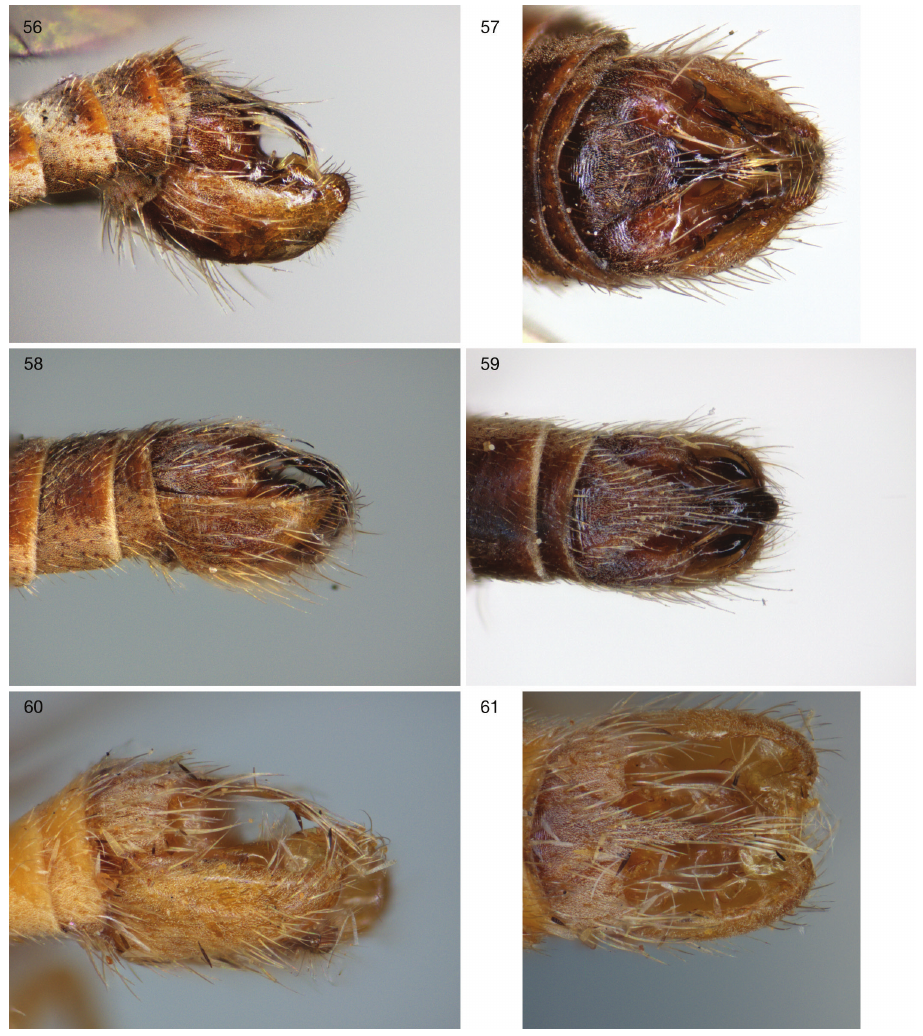
Figures 56–61. Photographs of ♂ terminalia (as in life rotated 180°): 56 Microphontes ericfisheri sp. n. (Holotype, USNMENT01115122), lateral (image flipped horizontally showing right side, Morphbank #861789) 57 same, ventral (#861791) 58 Microphontes jasonlondti sp. n. (Holotype, NMSA-DIP-4768), lateral (#861822) 59 same, ventral (#861824) 60 Microphontes megoura (Holotype, NMSA-DIP-4768), lateral (#861868) 61 same, ventral (#861870). Magnification: white macrosetose; mes femur orange to light brown, short white setose, yellowish macrosetose: 2 anterior proximally and medially, 2–3 anterior distally, 4 posterior dis- tally; mes tibia orange to light brown, short white setose, yellowish macrosetose: 5 in 1 dorsal row, 3 in 1 anterior row, 5 in 1 antero-dorsal row, 5 in 1 antero-ventral row, 6 in 1 postero-ventral row, distal tip with 8 long yellowish macrosetae; met coxa orange